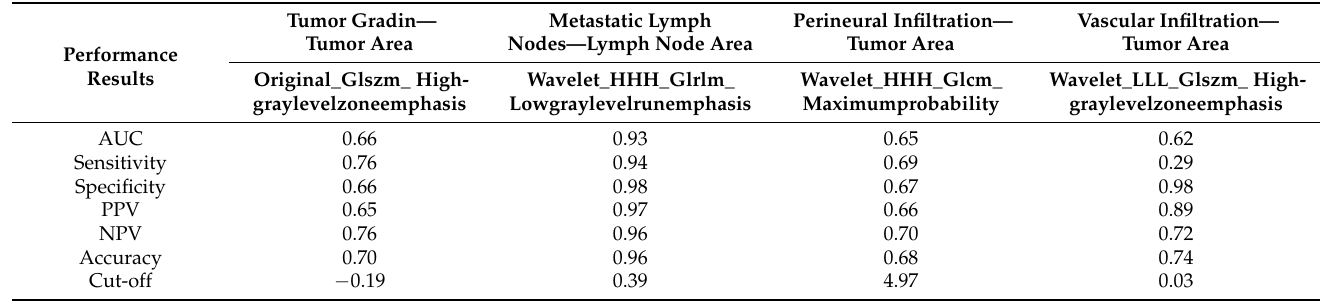
Table 2. Univariate analysis. Most significant results of the ROC analysis of radiomics features extracted from ROIs on both the tumor and lymph node